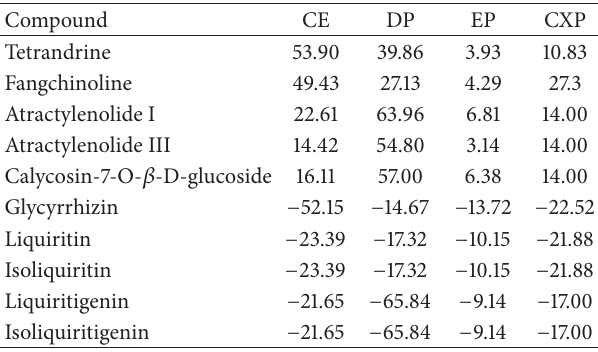
Table1:ListofselectedMRMparameters,includingCE,DP,EP,and CXP for the 10 major compounds of Fangji Huangqi